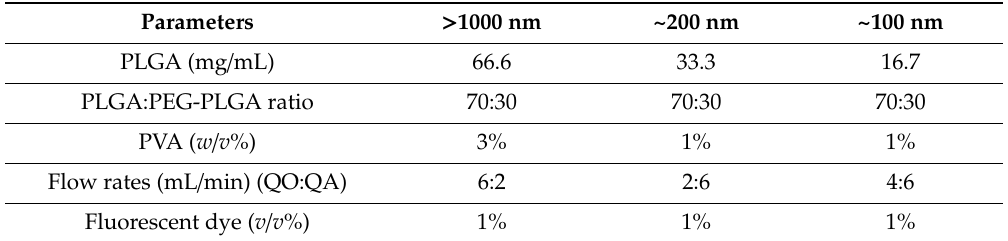
Table 1. Optimized formulation and process parameters to obtain PLGA particles with indicated size. PEG: polyethylene